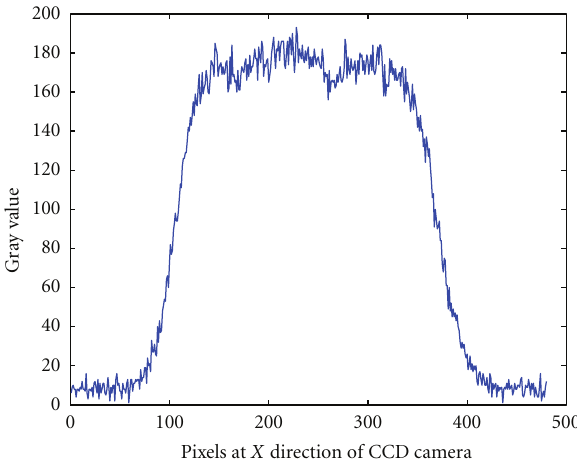
Figure 11: Vertical illumination distribution of concentration spot on the receiver.